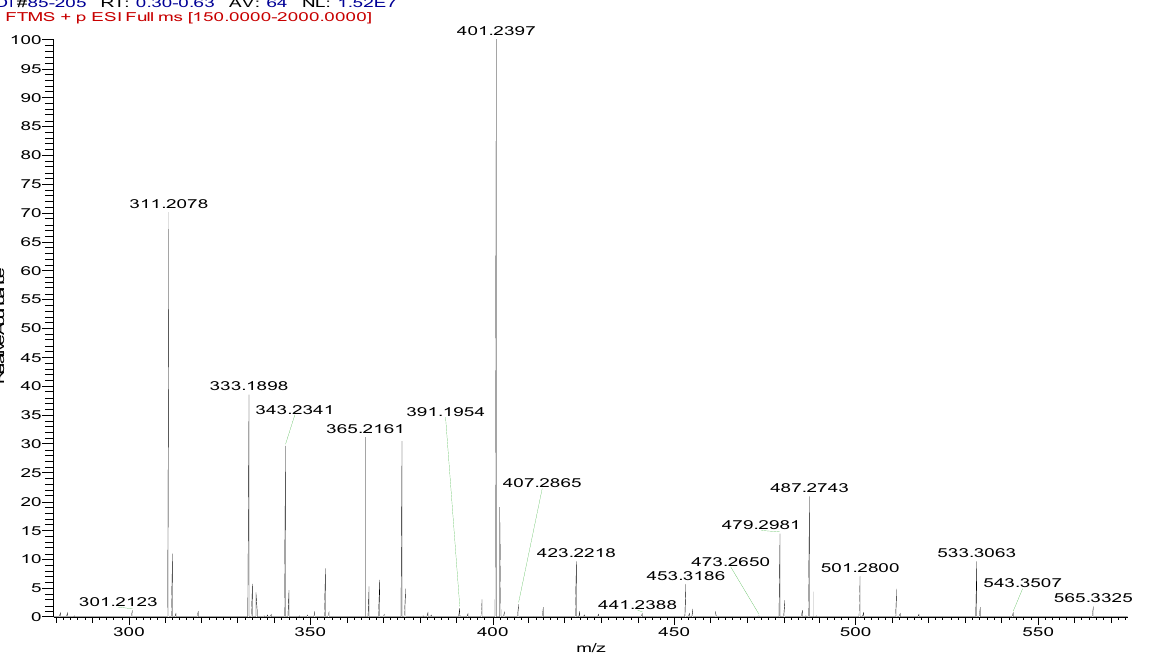
Figure 13. ESI mass spectrometry data for HDI.